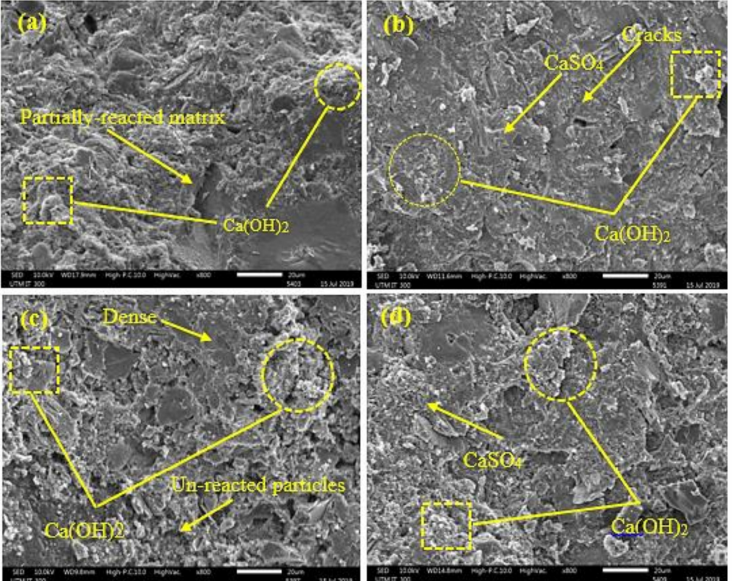
Figure 8. SEM micrographs of the ( a ) OPC based before ( c ) OPC based after, ( b ) GBFS modified before ( d ) GBFS modified after exposure to 10% of H 2 SO 4 solution for 365